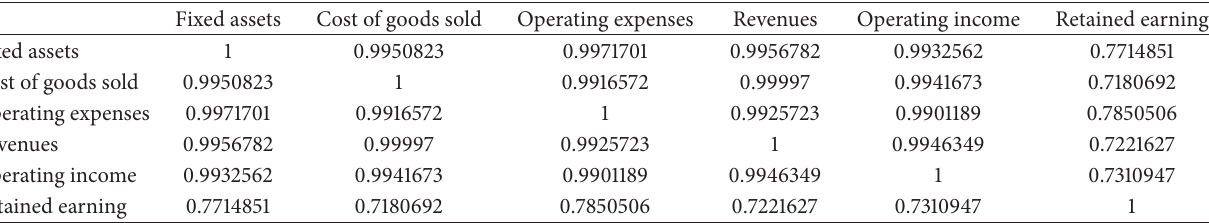
Table 9: Correlation of input and output data in 2011.